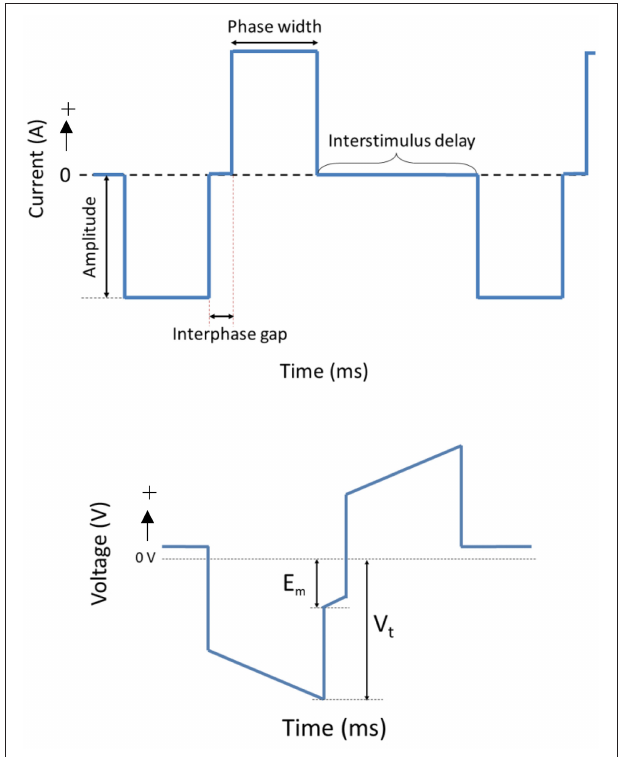
FIGURE 2 | A schematic of a cathodic first biphasic current and transient voltage